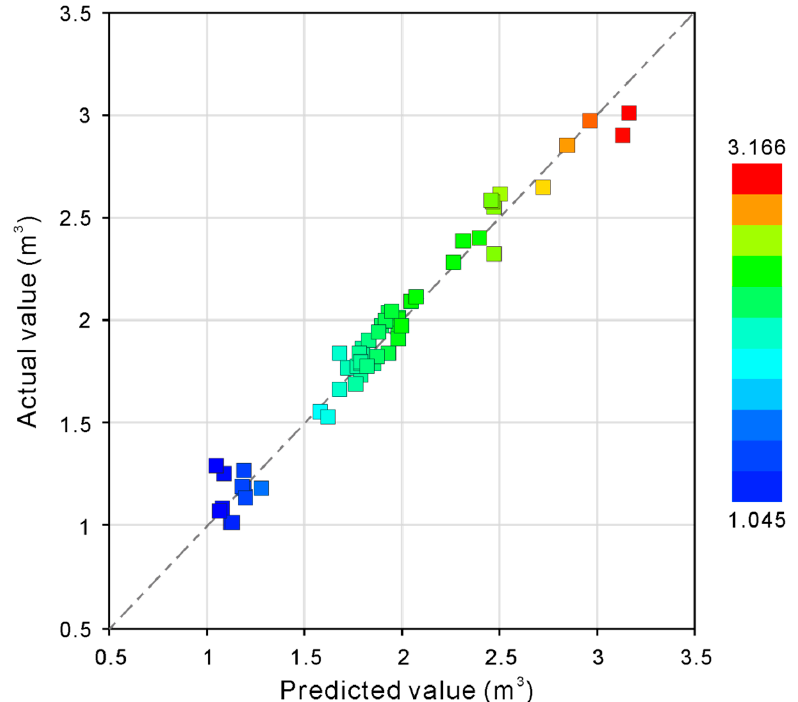
Figure 10. The cross plot of actual value against the predicted value of SRV.